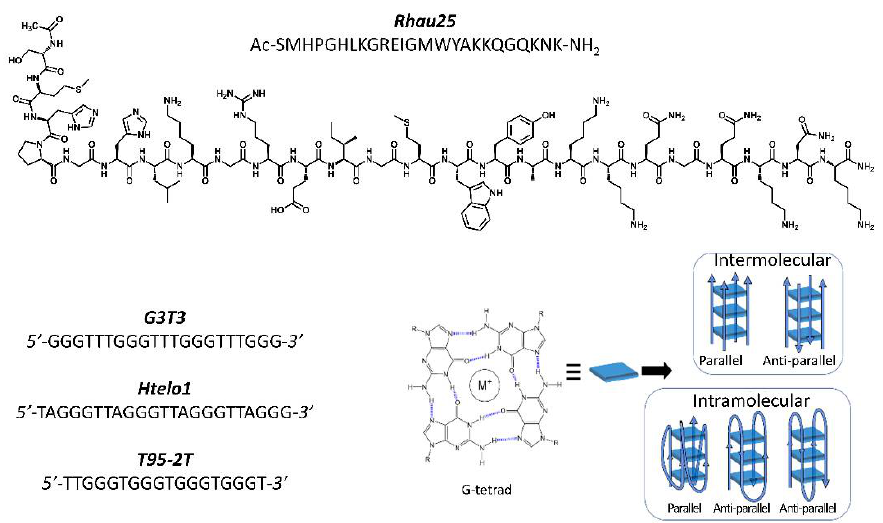
Figure 1. Sequences of the synthetized Rhau25 peptide and G3T3 , Htelo1 and T95-2T G-quadruplex- forming oligonucleotide sequences with cartoons of the peptide Rhau25 , G-tetrad and G4 topologies. The highest abundance of putative G-quadruplexes sequences is located at telom- eres [14], which protect chromosomes from degradation, end-to-end fusions, and are recognized as double-strand break sites [15]. In most telomeric DNAs, guanines and strand running 5 (cid:48) to 3 (cid:48) from the centromere to the telomere